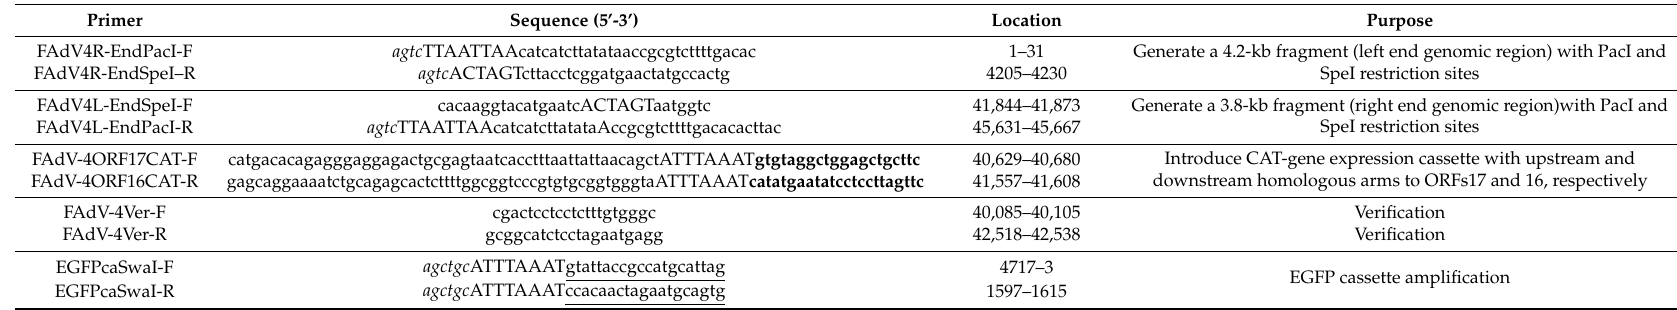
Table 1. List of